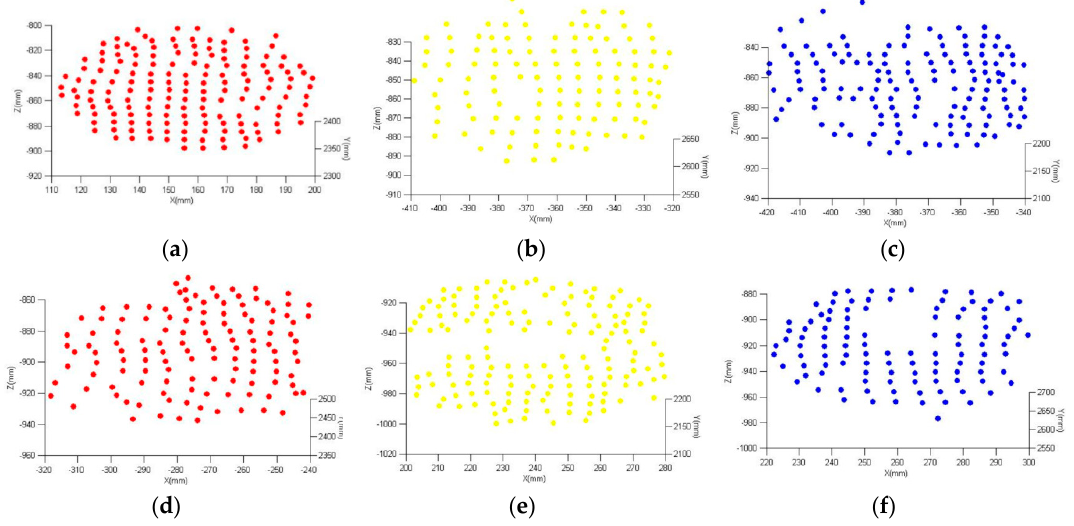
Figure 3. Point cloud image for a fruit tree under different visual angles: ( a ) point cloud coordinate: PointCloud1; ( b ) point cloud coordinate: PointCloud2.